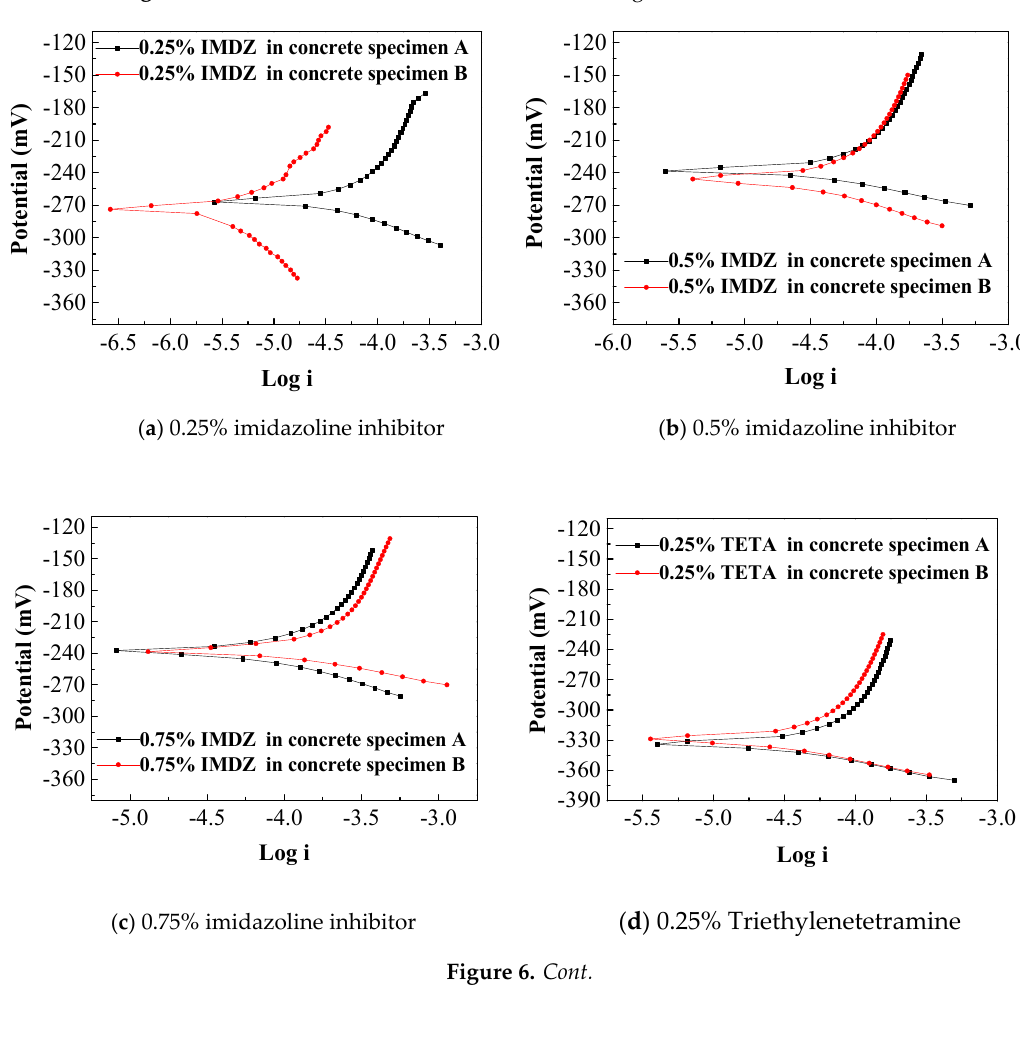
Figure 5. Polarization curves of a steel bar with a high concentration of inhibitor.